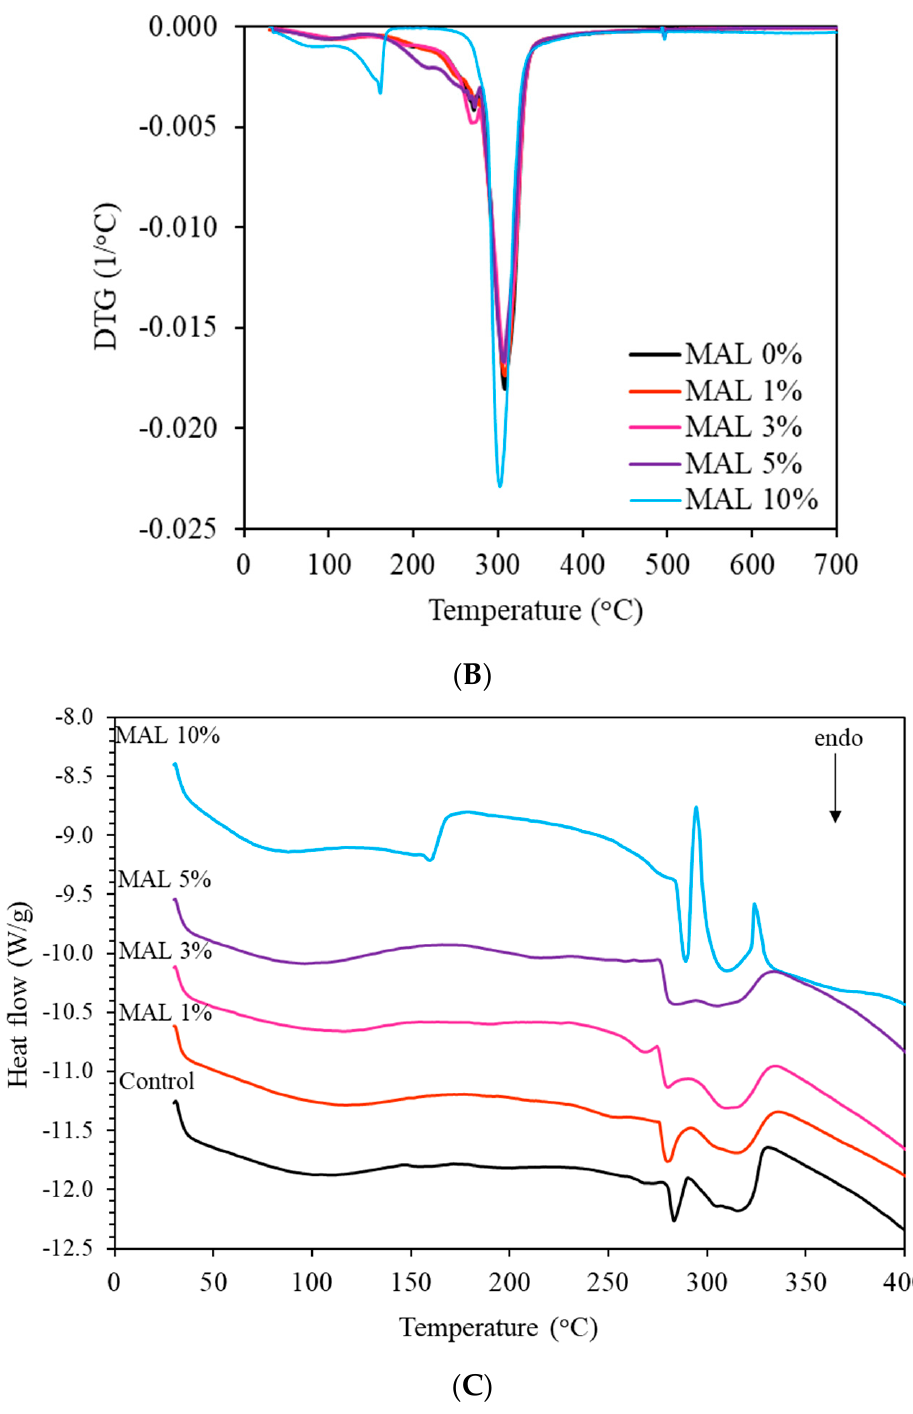
Figure 4. Thermal degradation behavior as ( A ) weight loss, ( B ) first derivative weight loss and ( C ) DSC thermograms of starch films containing maltol (MAL) at 0, 1, 3, 5 and 10%.